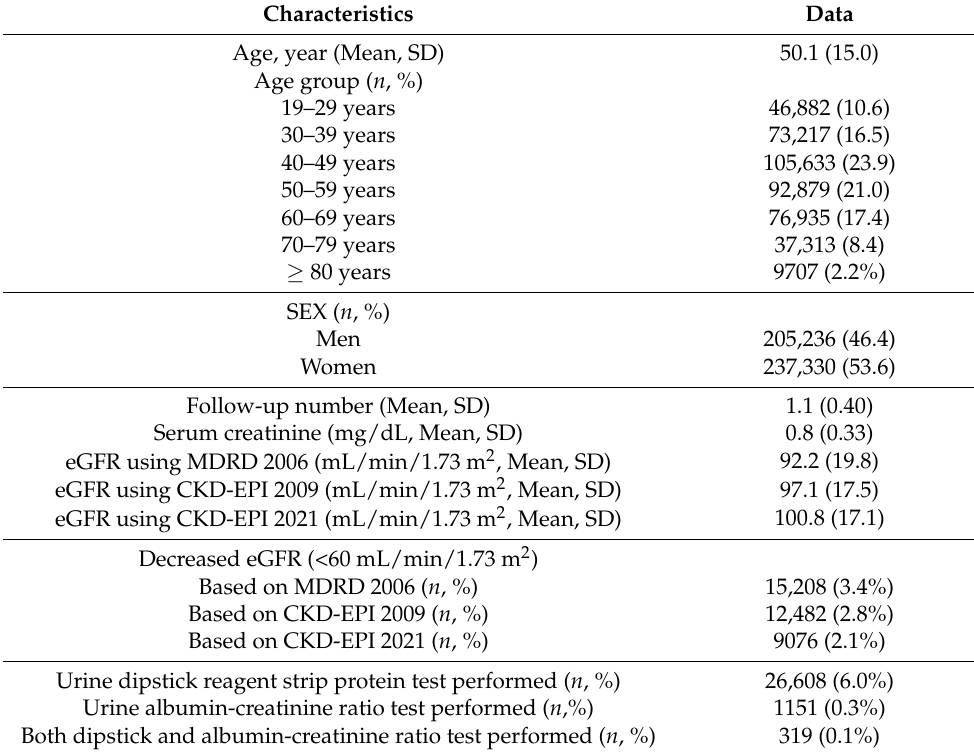
Table 1. Baseline characteristics of 442,566 study subjects visiting local clinics and hospitals for health